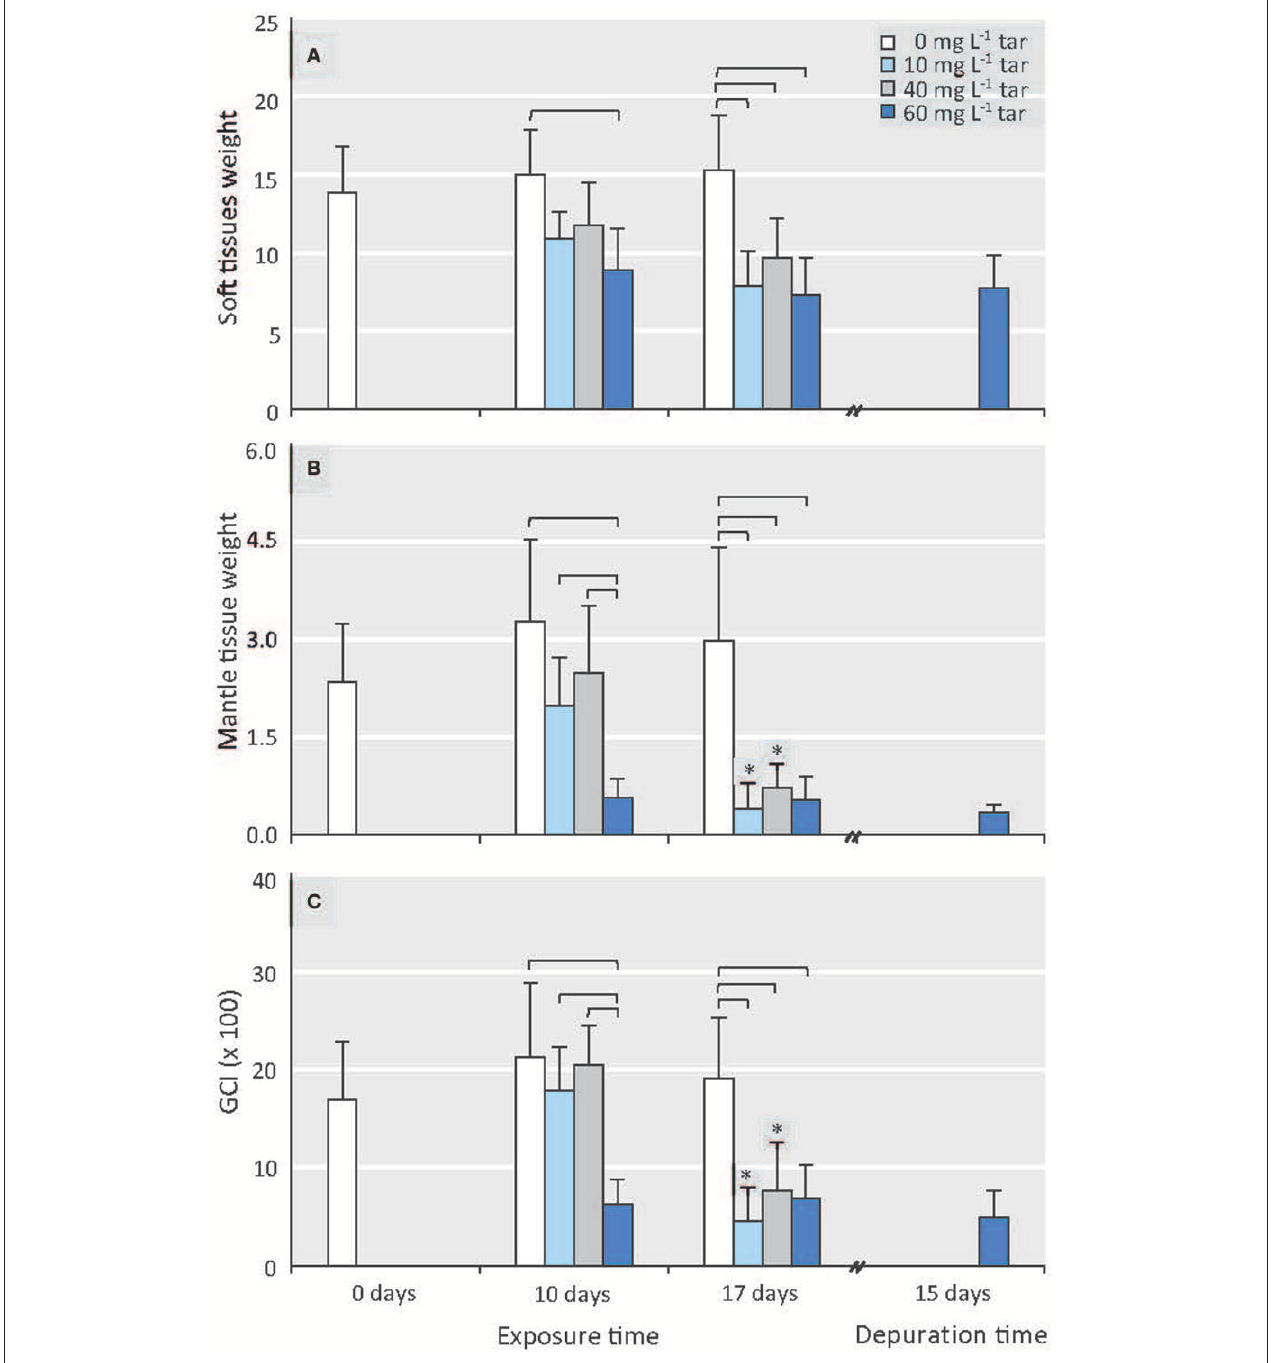
FIGURE 1 | Effect of different tar concentrations and exposure times on biometric parameters. (A) Soft tissues weight. (B) Mantle tissue (gonad) weight. (C) GCI. Data are means ± SD, n ≥ 8. Reference mussels (0mg L − 1 tar). Square brackets represent significance differences between mussels exposed to different tar concentrations during same time ( p < 0.001). Significance differences between mussels exposed to each of the tar concentrations at different times: * p < 0.01.